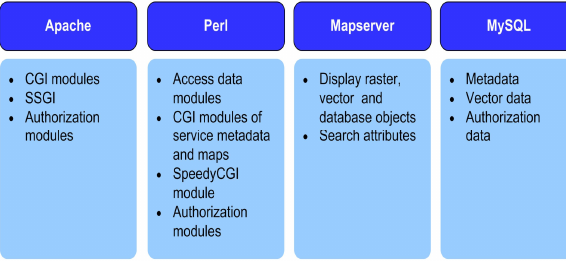
Fig.6. IRIB specific implementation